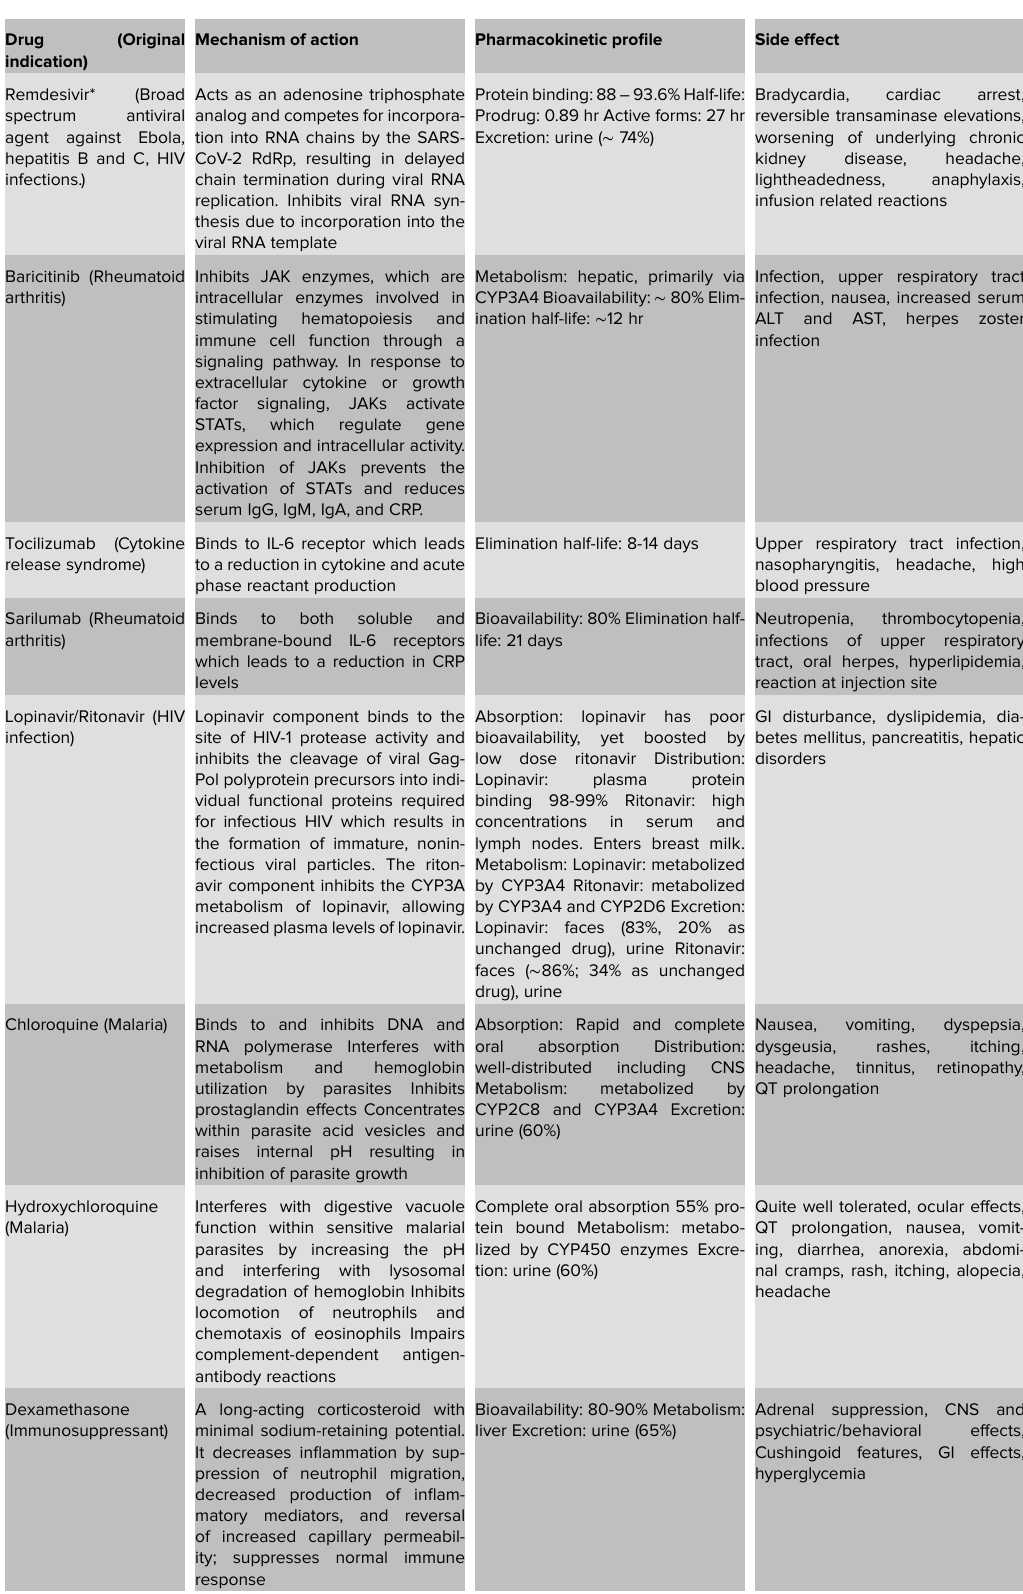
Table 3: Pharmacology of clinically repurposed drugs to treat COVID-19 [100,